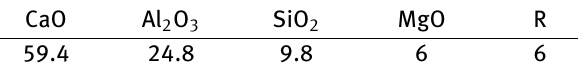
Table 2: Compositions of the high basicity refining slag, %.